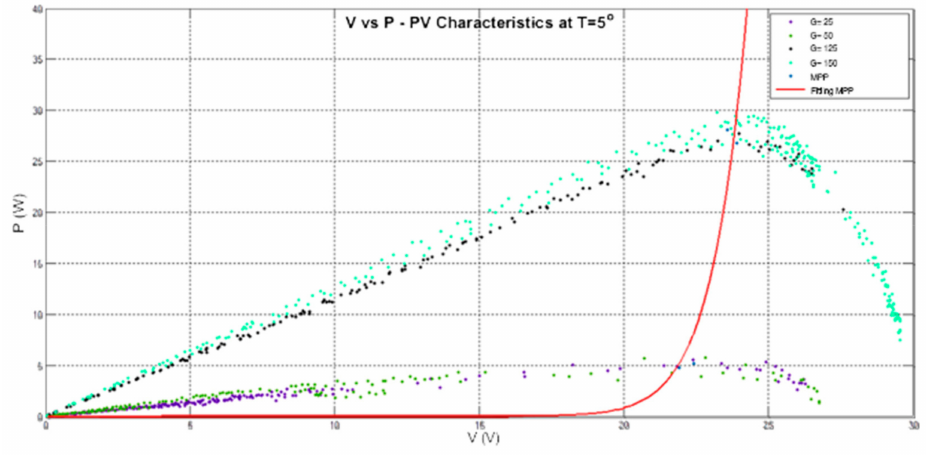
Figure 5. MPPT Curve at T = 5 ◦ C.